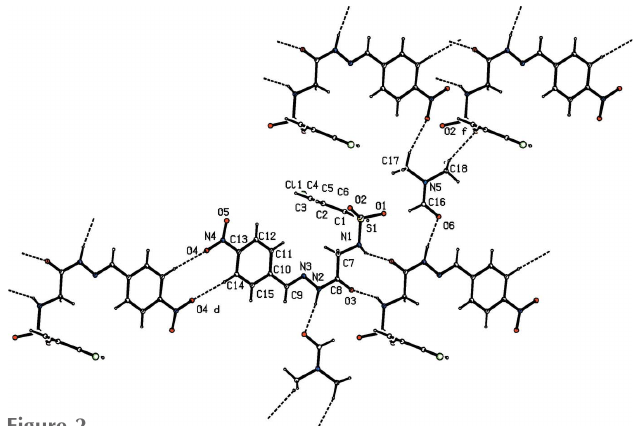
Figure 2 The hydrogen-bonding pattern (dashed lines) in the title compound.